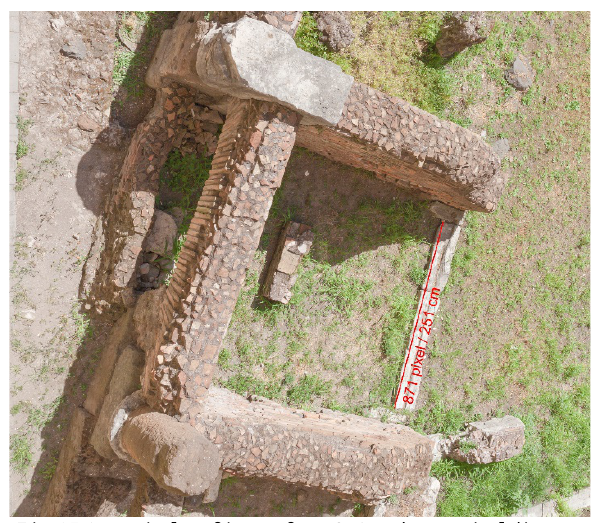
Fig. 15 A particular of image from S. Omobono: pixel distance and measured distance from the center of original